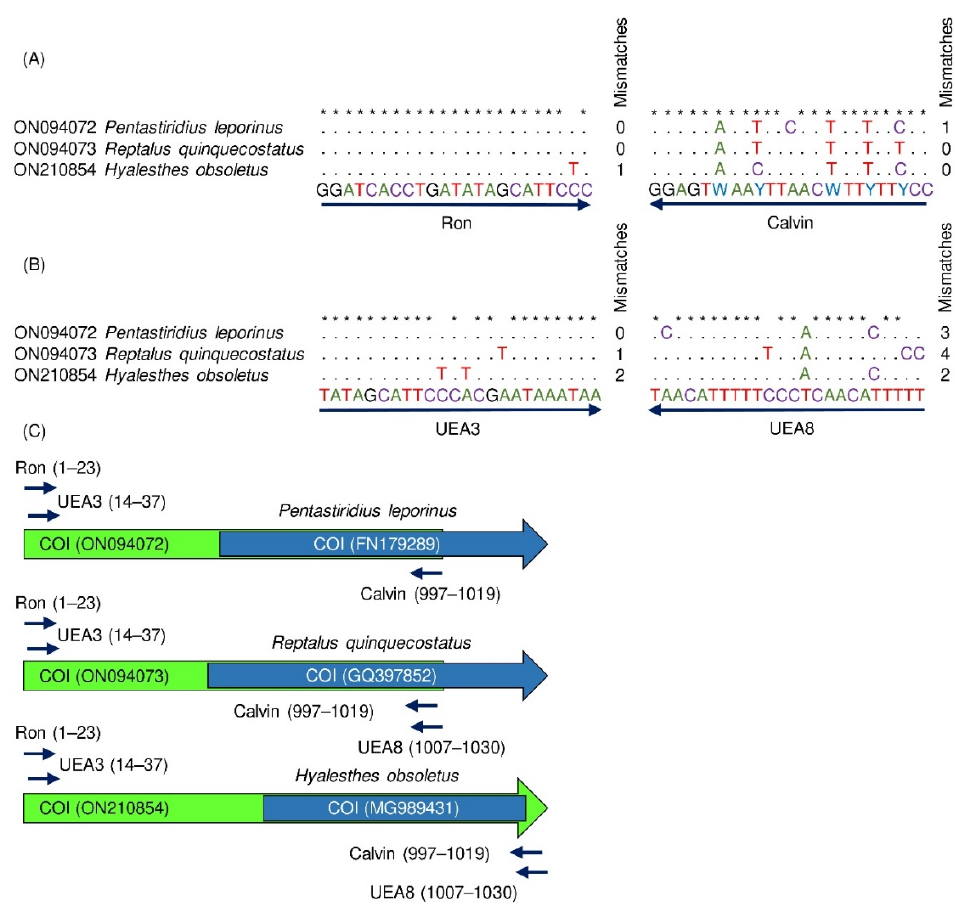
Figure 3. Alignment of the universal primers (Ron/Calvin and UEA3/UEA8) to P. leporinus , R. quin- quecostatus , and H. obsoletus COI sequences and primer location within the COI gene. Alignment of ( A ) Ron/Calvin and ( B ) UEA3/UEA8 primers to the COI gene of P. leporinus , R. quinquecostatus , and H. obsoletus . Dots mark identical nucleotides in the primers and the analyzed sequences. Asterisks mark the positions of conserved nucleotides within primer sequences. Nucleotide mismatches be- tween primers and analyzed sequences including numbers are indicated for each sequence. ( C ) P. leporinus , R. quinquecostatus , and H. obsoletus COI schematic maps. Arrows represent the locations of the primers on the COI gene and show that Ron and UEA3 as well as Calvin and UEA8 partly over- lapped. The green color shows the fragment that was amplified and sequenced in this study for each species. The blue color shows the available sequence from the NCBI database.